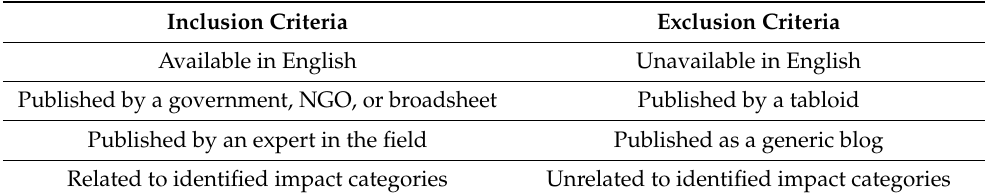
Table 1. Inclusion and exclusions criteria for the literature review.